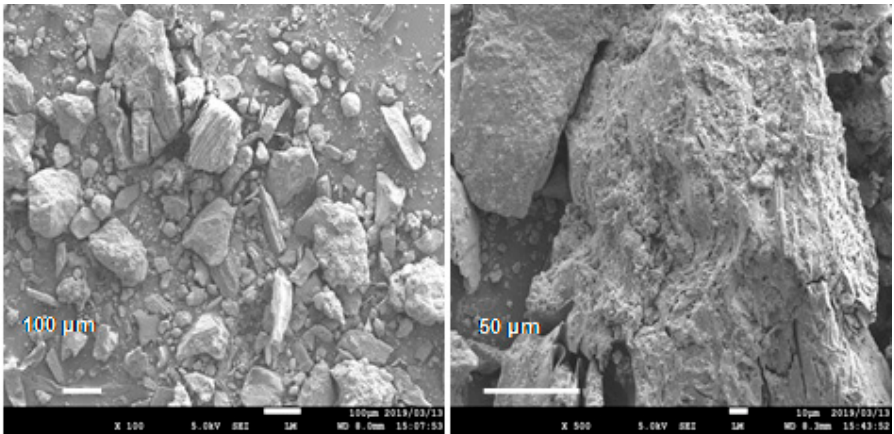
Figure 2. SEM images of conductive material (amorphous carbon) of